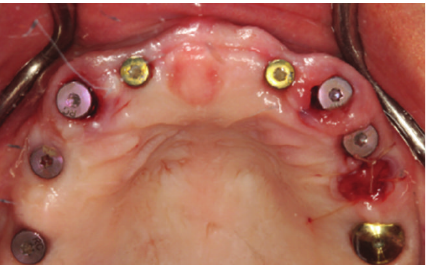
Figure 10: Flapless immediate one-stage implant placement at # 6 and # 11 extraction sockets.